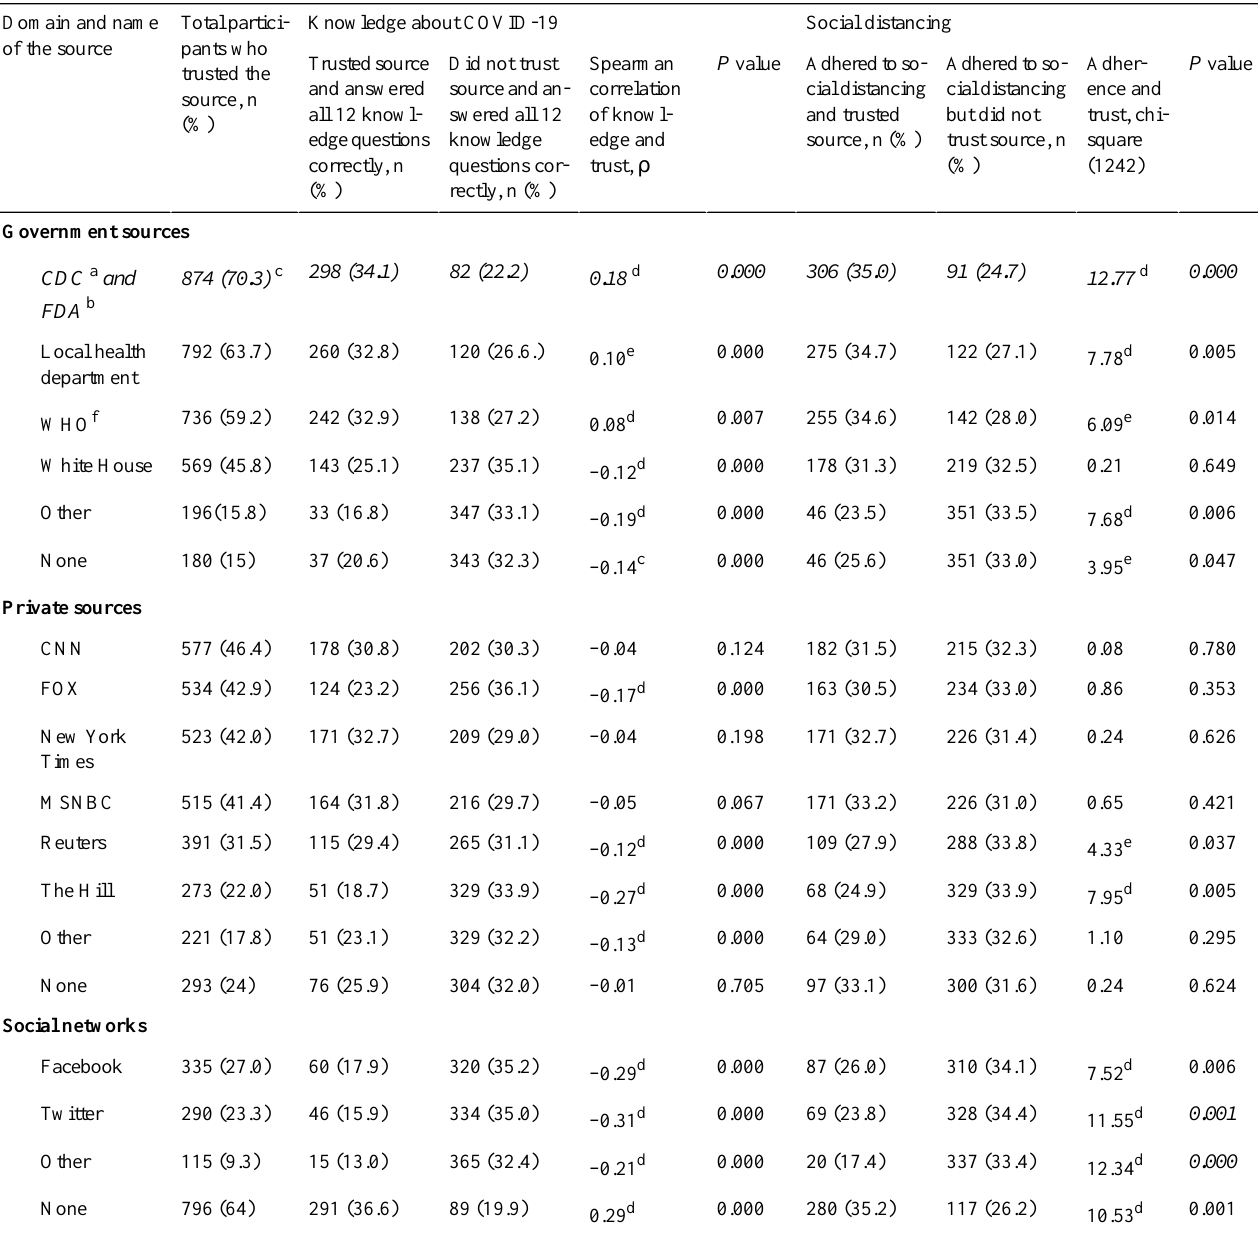
Table 5. Associations of trust in individual information sources with knowledge about COVID-19 and with adherence to social distancing